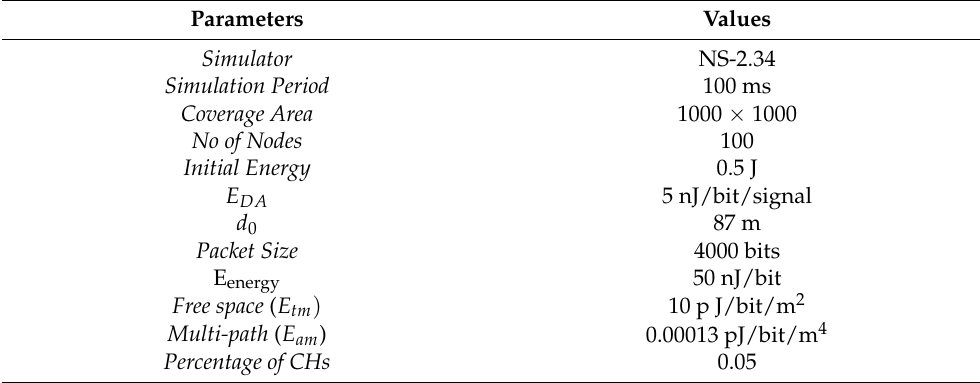
Table 1. Simulation parameters details of the proposed model.